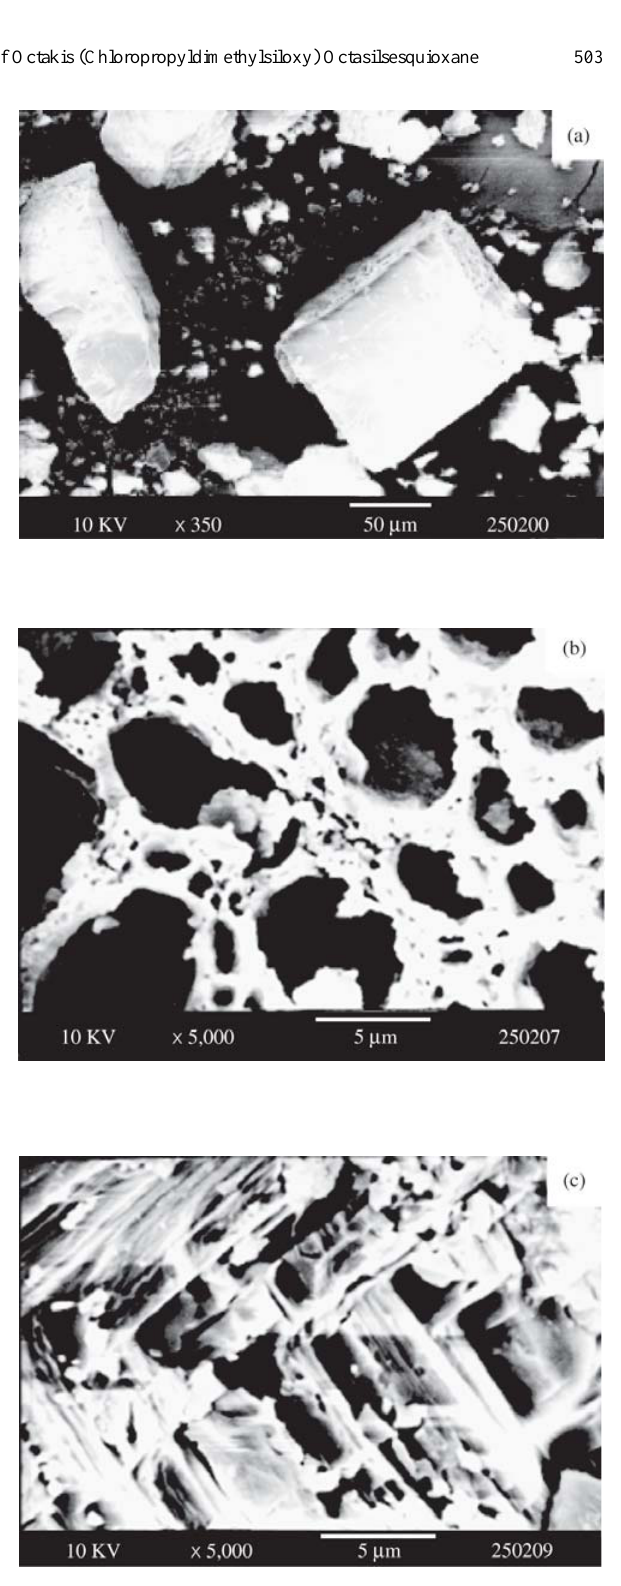
Figure 4. Scanning electron micrograph of: a) cubes, × 350; b) cubes, × 5000; c) octakis (chloropropyldimethylsiloxy) octasilsesquioxane ×